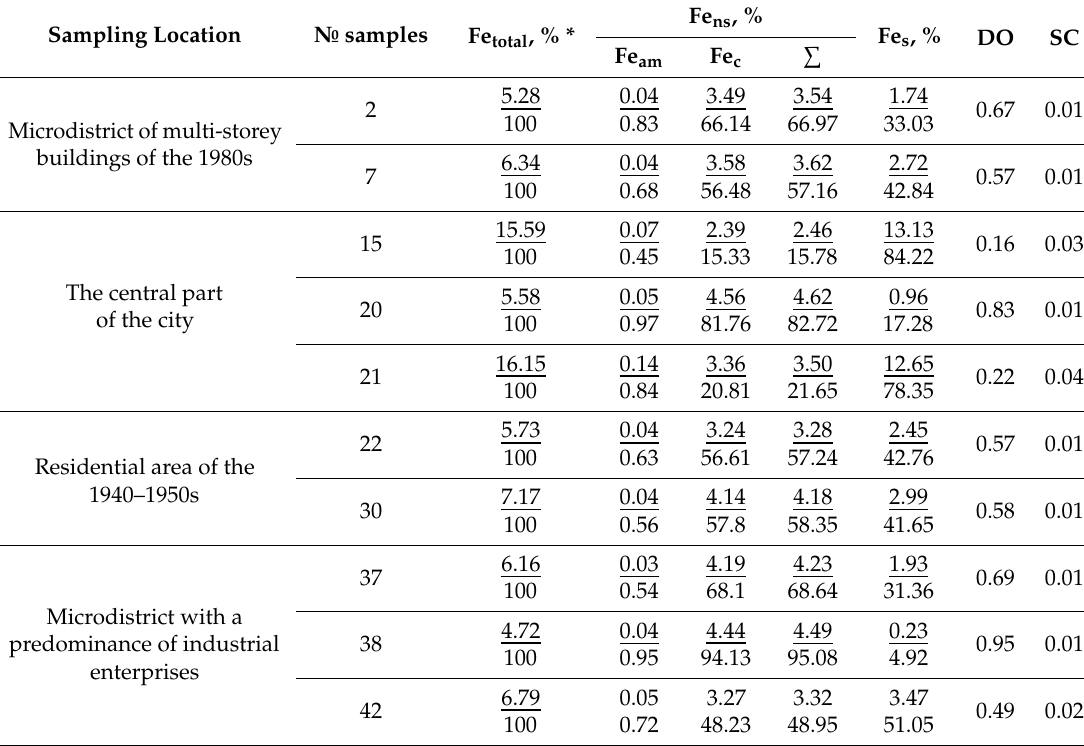
Table 5. Forms of iron compounds in soil of surface horizons (0–10 cm) of Gubakha.